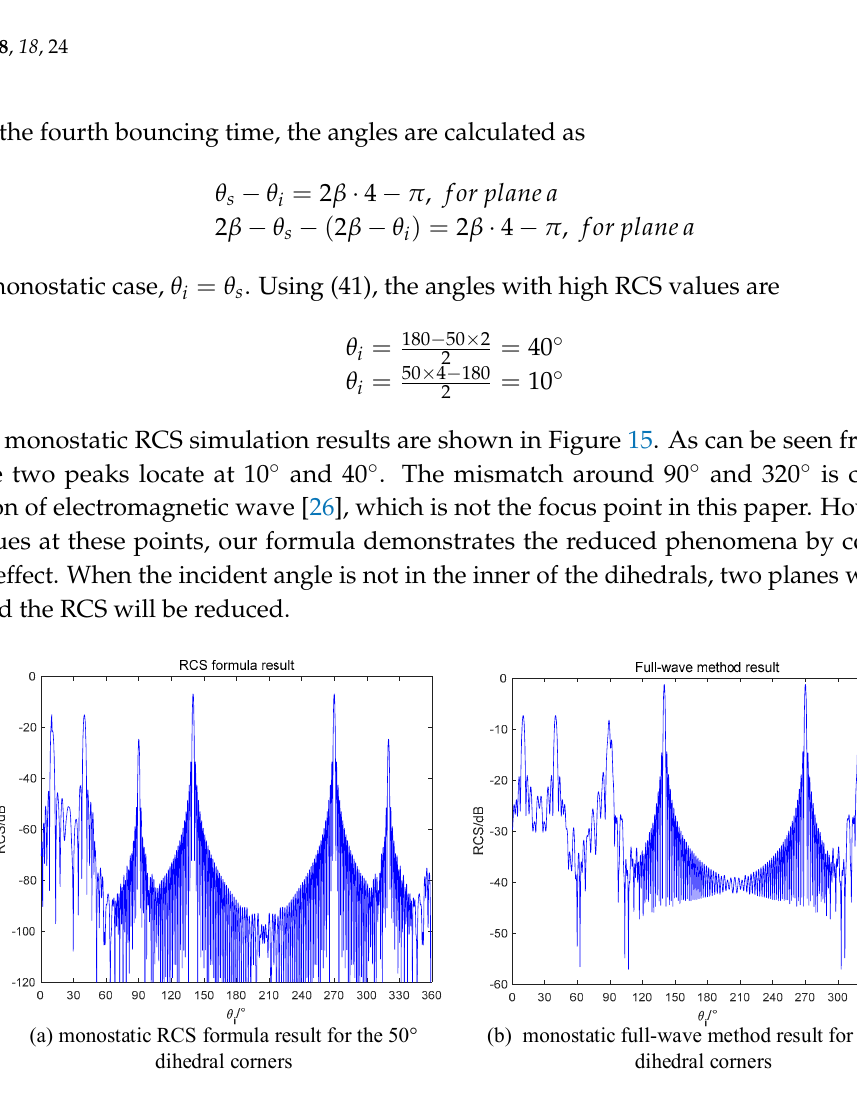
Figure 16. Monostatic RCS of the 50° dihedral ( a ) RCS formula in this paper; ( b ) Full-wave method.